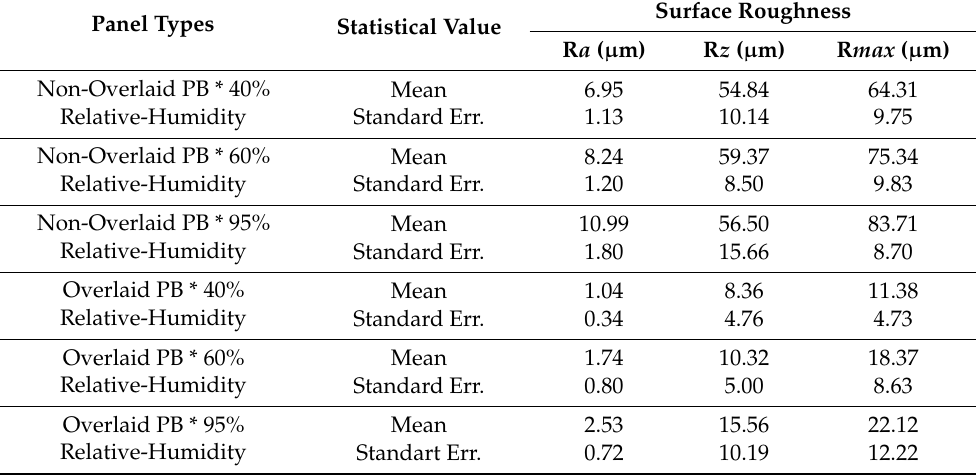
Table 2. Average surface roughness (R a ) values of particleboard panels.